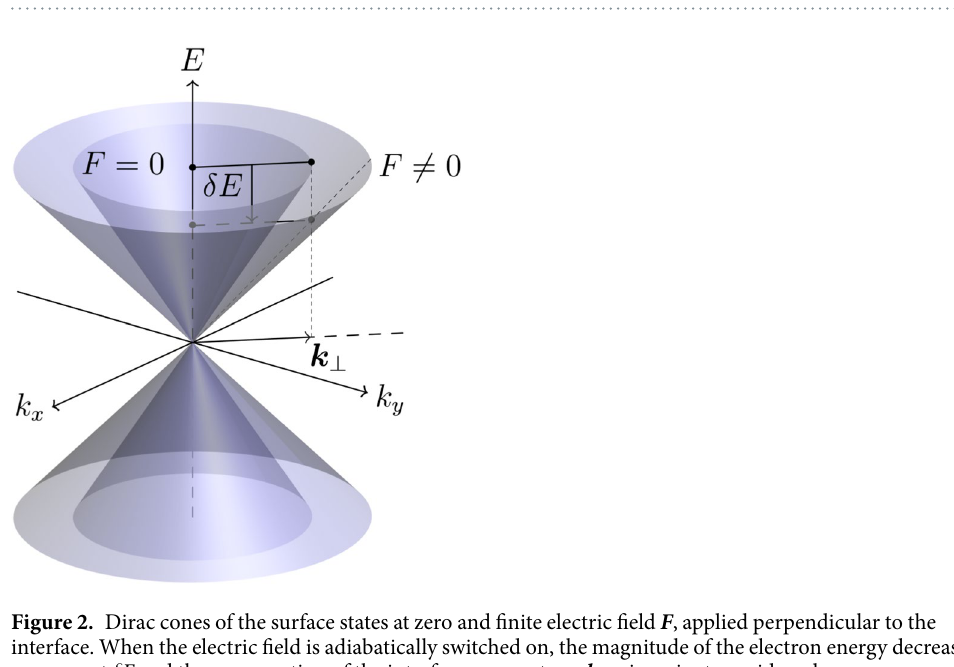
Figure 1. ( a ) Energy as a function of the interface momentum for two values of the electric field. Solid lines correspond to the approximate result (8a). The dispersion grows faster than linear only at high field. ( b ) Fermi velocity as a function of the the electric field for two different values of the interface momentum. Solid line displays the quantum-confined Stark effect predicted by (9). ( c ) Level width as a function of the inverse of the electric field for | k ⊥ | d = 0.2 (circles) and | k ⊥ | d = 0.3 (squares). Solid lines depict the approximation given in (8b).